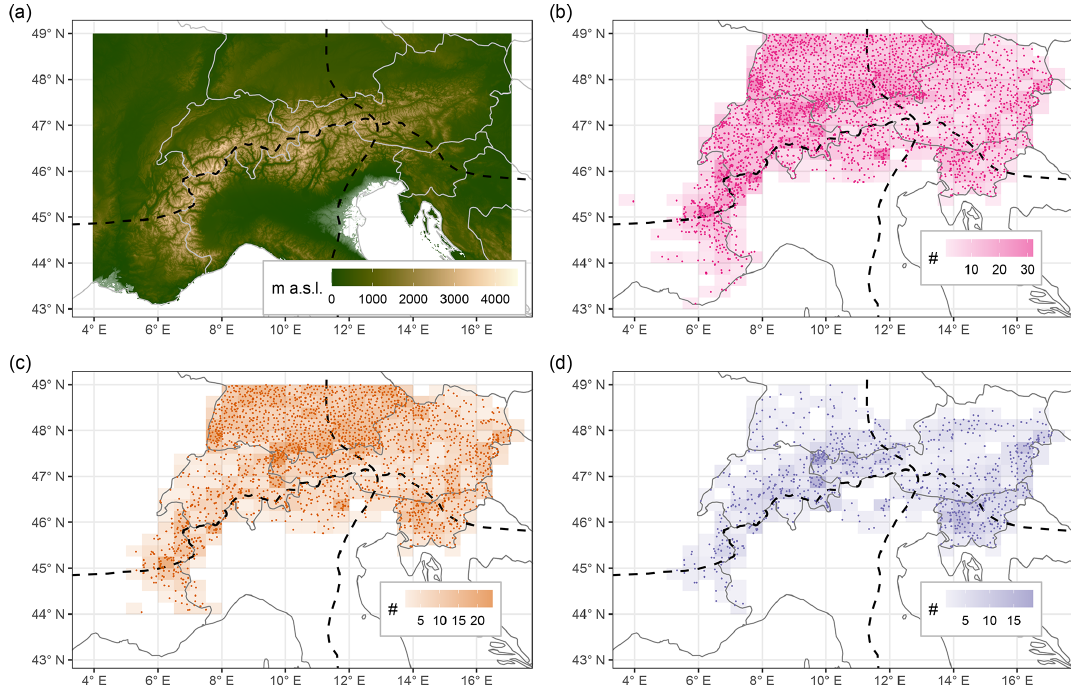
Figure 1. Topography of the European Alps (a) and overview of station locations (b–d) . Panel (a) shows the SRTM30 DEM (Shuttle Radar Topography Mission digital elevation model) with ∼ 1km resolution. Panel (b) shows the location of snow depth measurement locations that were available (provided). Panel (c) shows the locations of stations used in the regionalization analysis. Panel (d) shows the stations used for the long-term trend analysis. The station density for a 0.5 ◦ × 0.25 ◦ grid is shown underneath the points in (b–d) . The main climatic divides from Auer et al. (2007) are shown as dashed lines in (a–d) . See also Appendix A and Sects. 2.4 and 2.5 for selection criteria. Table 1. Overview of the number of stations with daily data provided by the different data sources. The data source consists of a country abbreviation, followed by the data source. Country abbreviations are AT for Austria, CH for Switzerland, DE for Germany, FR for France, IT for Italy, and SI for Slovenia. For source abbreviations, please see Sect. 2.2. Station numbers are shown for depth of snowfall (HN) and snow depth (HS) time series. See Appendix A and Sects. 2.4 and 2.5 for more details on station selection procedures associated with the different types of analyses. HN was not analysed but was used for checking